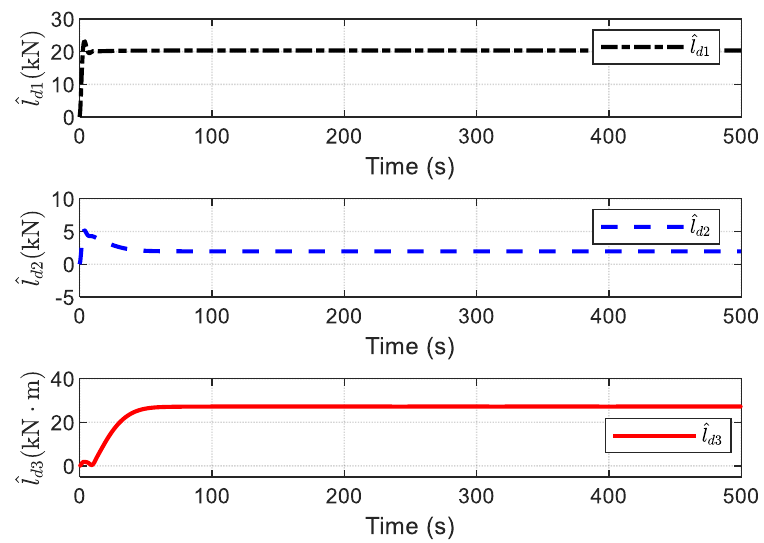
Figure 23. Estimation of the upper bound of the disturbances via ADO.